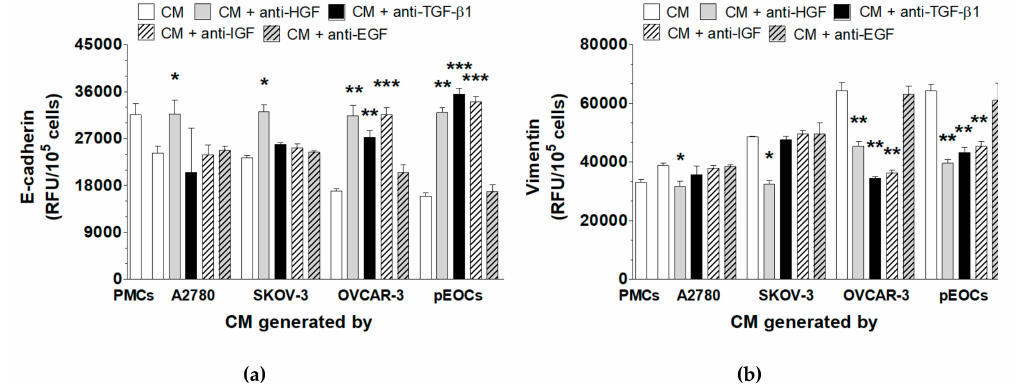
Figure 5. Identification of the cancer-derived mediators of MMT in PMCs. Expression of E-cadherin ( a ) and vimentin ( b ) in the PMCs whose exposure to autologous and cancer-derived CM was proceeded with a preincubation of the cancer-derived CM with specific neutralizing antibodies against HGF, TGF- β 1, IGF-1, or EGF. Experiments were performed with eight separate cultures of PMCs obtained from di ff erent donors, with eight separate cultures of primary epithelial cancer cells (pEOC), and with eight separate cultures of each established cancer cell line. The results are expressed as the mean ± SEM. *, p < 0.05 vs. PMCs; **, p < 0.01 vs. PMCs; ***, p < 0.001 vs. PMCs. RFU, relative fluorescence